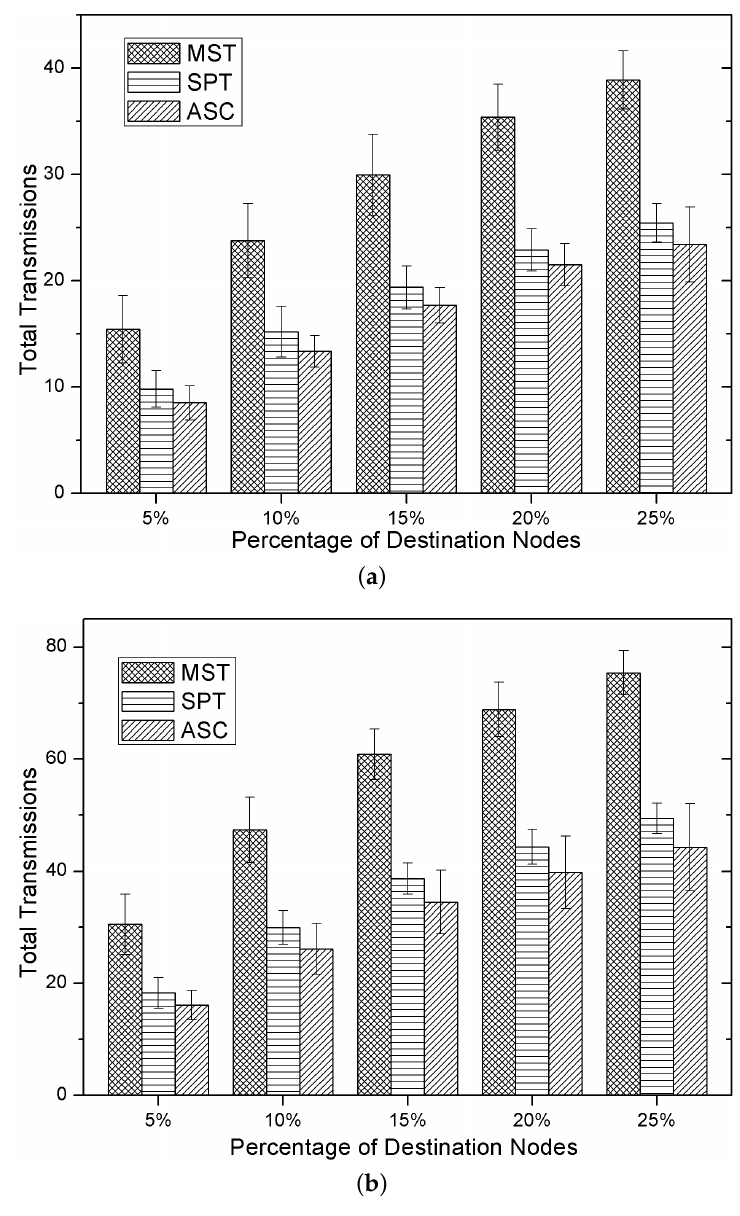
Figure 4. The total number of transmissions. ( a ) |V| = 100; ( b ) |V| =